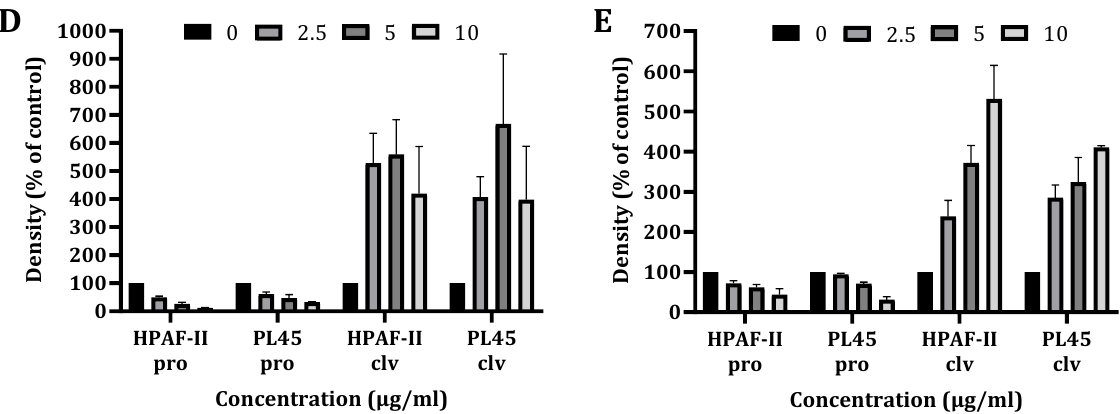
Figure 3. Western blot analysis of the caspases and PARP. HPAF-II and PL45 cells were treated with CSE (2.5, 5 and 10 µg/mL) for 4 h. Representative results ( A ), Specific antibodies for caspase-9 ( B ), caspase-8 ( C ), caspase-3 ( D ) and PARP ( E ) were used. β-Actin was used as the loading control.